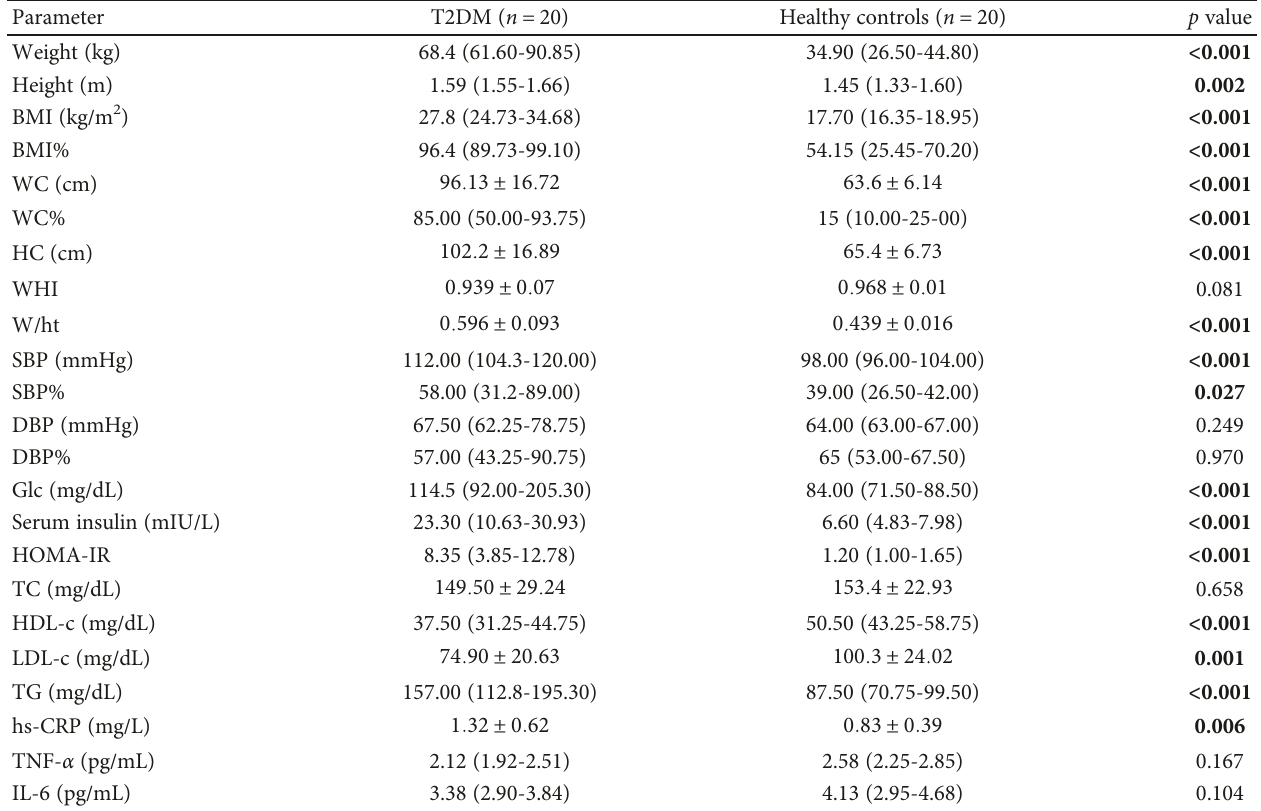
Table 2: Anthropometric, metabolic, clinical, and in fl ammatory parameters for the T2DM and healthy control groups. Parameter